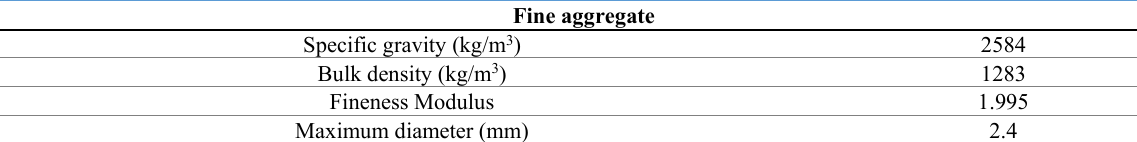
Table 2. Fine aggregate